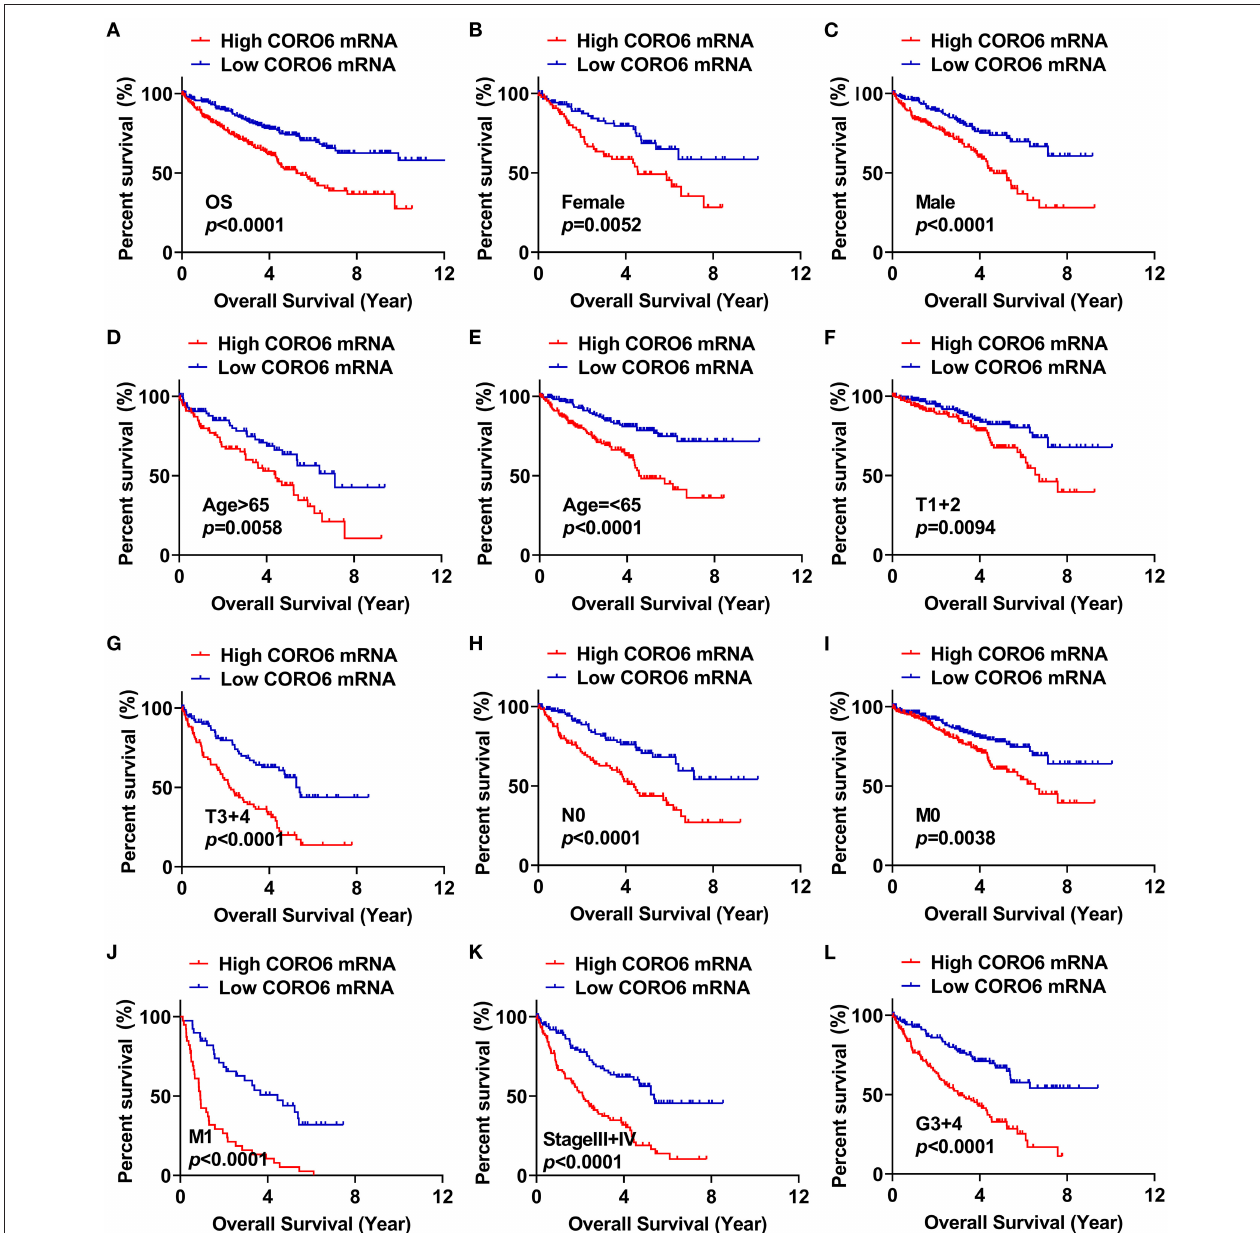
FIGURE 3 | CORO6 level was highly correlated with the OS of ccRCC patients. (A) CcRCC patients with a high expression level of CORO6 had a shorter OS time. (B–L) OS analyses of CORO6 in ccRCC patients classified by female (B) , male (C) , age > 65 (D) , age ≤ 65 (E) , T1 + T2 (F) , T3 + T4 (G) , N0 (H) , M0 (J) , M1 (K) , TNM stage III + IV (M) , and G3 + G4 (L)